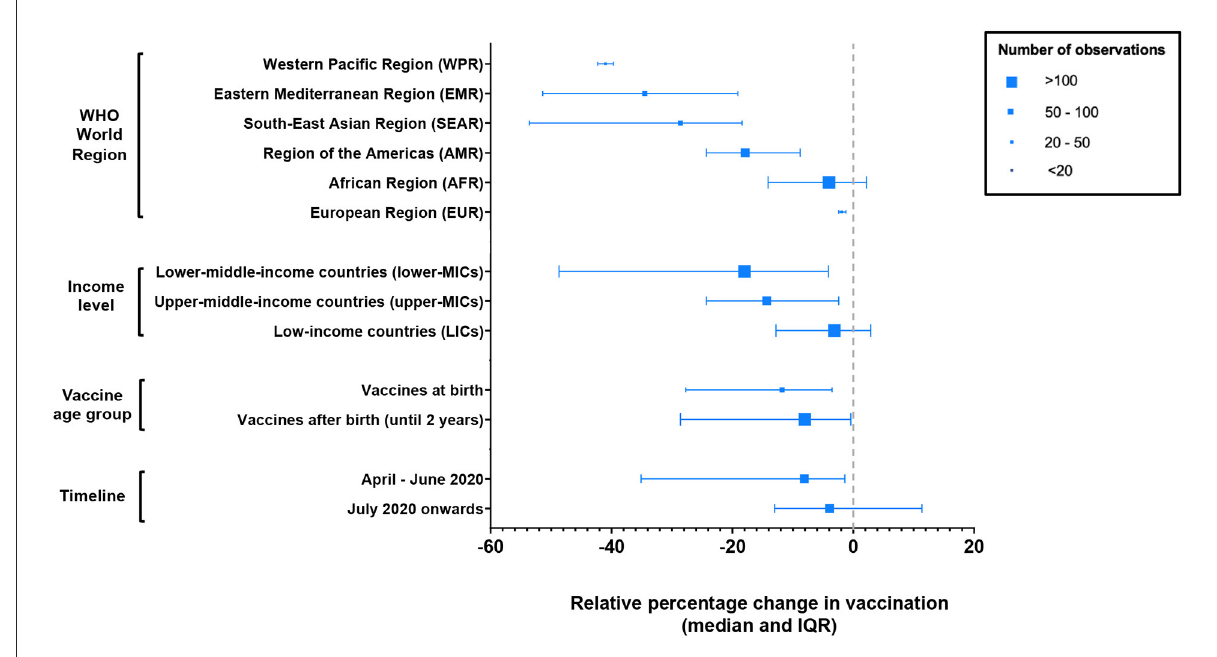
FIGURE4 Median relative percentage change ( ± IQR) in vaccination by WHO world region, income level and vaccine age